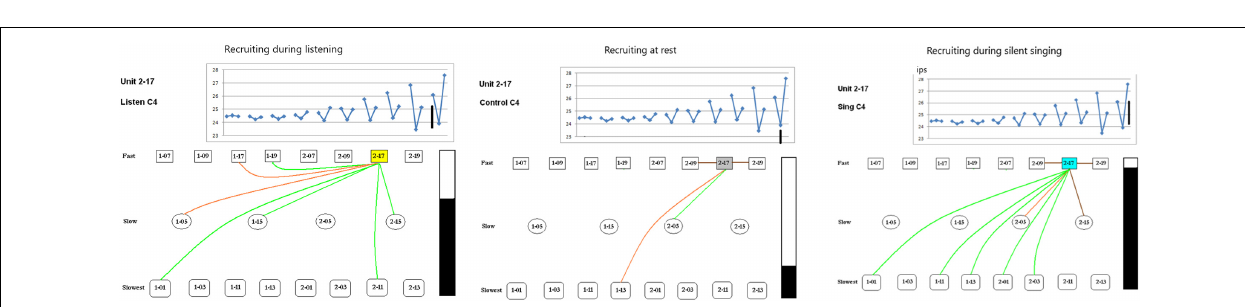
Frontiers in Human Neuroscience |